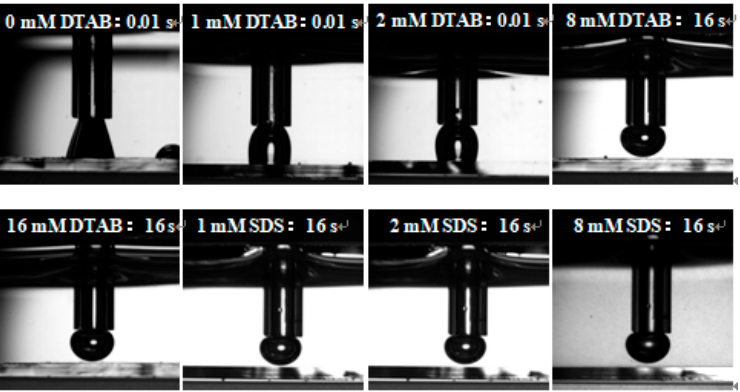
Figure 10. Effect of DTAB and SDS on the attachment behaviour between hydrophobic glass microsphere and bubble.